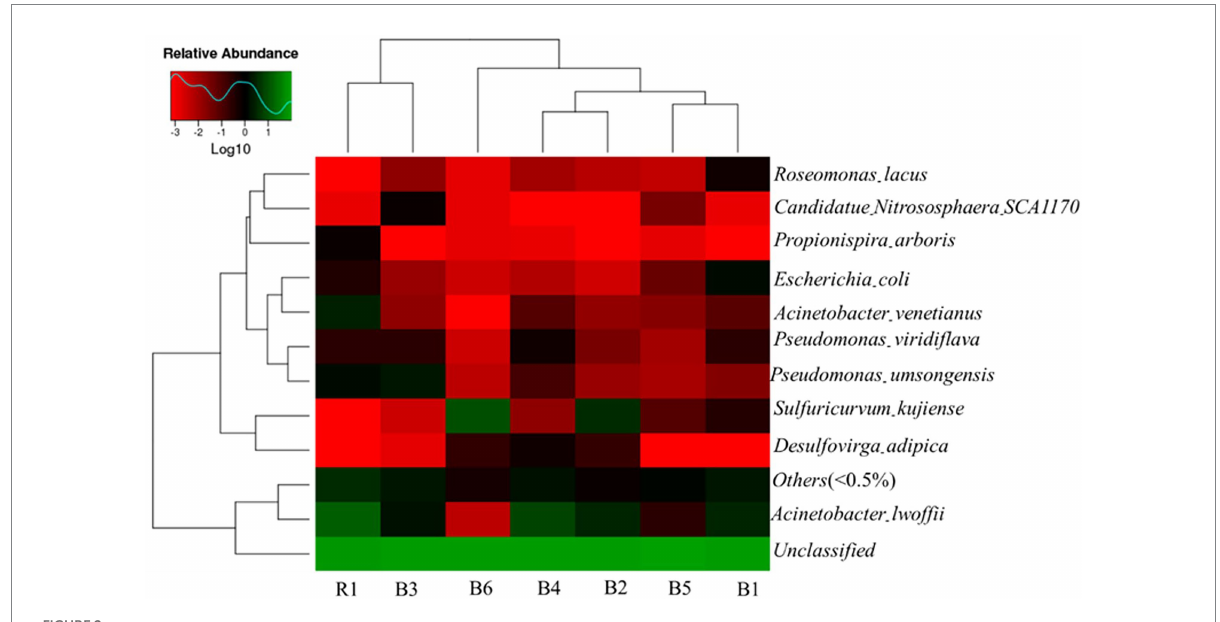
FIGURE 2 Heatmap of species relative abundance among different samples.